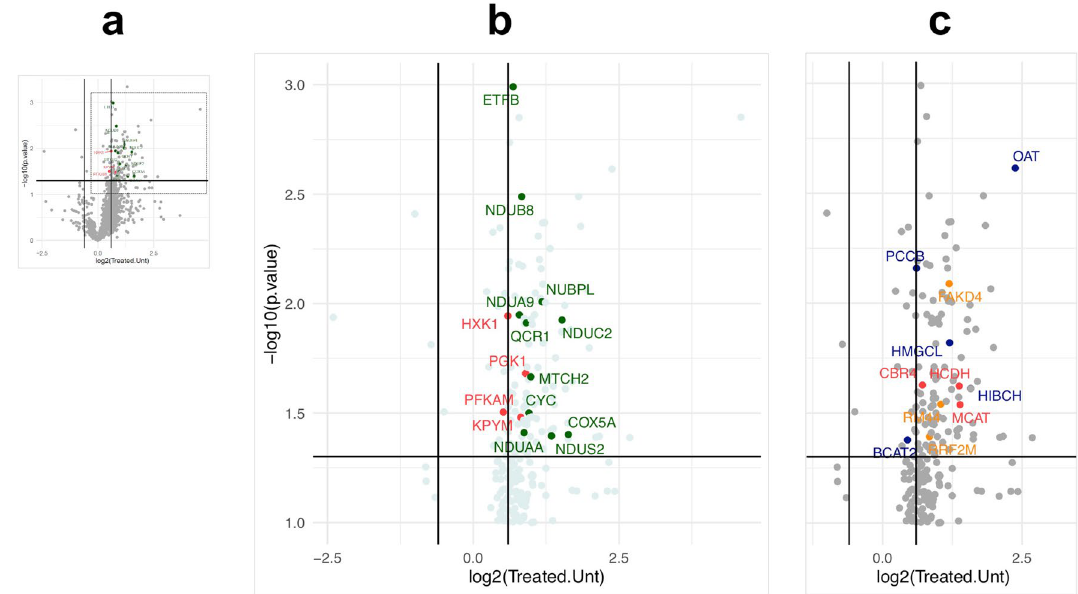
Figure 1. Volcano plots of quantitative proteomic analysis of hearts of control and 2DG treated mice. ( a ) In miniature, fold-change and significance of all 1237 proteins identified in hearts of 2DG-treated mice versus controls. ( b ) Magnified region showing the significantly altered individual proteins related to the respiratory chain (green) and glycolysis (HXK1, PFKAM, PGK1, TPIS and KPYM) (red) (see Table S4 for the complete list and individual scores). ( c ) Magnified region of the volcano plot showing the significantly altered proteins related to mitochondrial branched-chain amino acid catabolism BCAT2, HMGCL, HIBCH, and PCCB, in blue, and OAT (which is involved in amino acid inter-conversion, as well as synthesis); 3 proteins in orange related to mtDNA expression (RRF2M, RM44, FAKD4), whereas three proteins of fatty acid metabolism, HCDH, MCAT and CBR4, are marked in red. Other components of the mitochondrial proteome significantly altered by the 2DG treatment (not highlighted) were two proteins related to mitochondrial morphology and division MTFP1, OXNAD1 (unknown